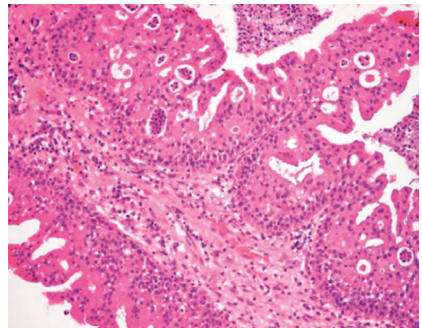
Figure 3: Pathological section view of